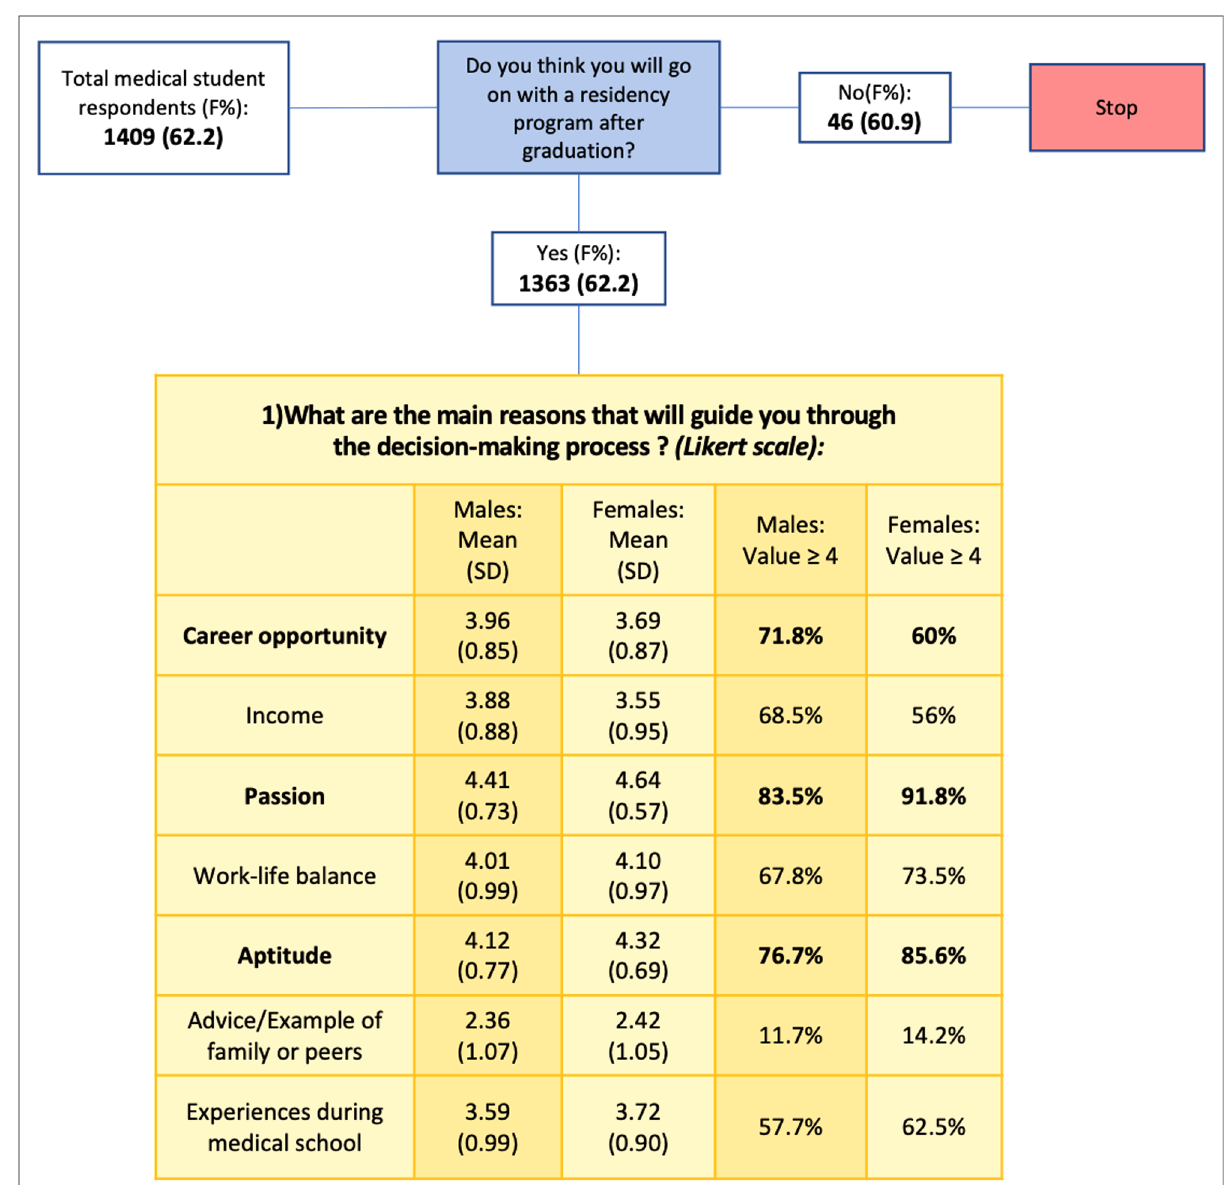
FIGURE 4 Reasons guiding the decision-making process of a program, with male and female respondents expressed as mean, standard deviation (SD), and values ≥